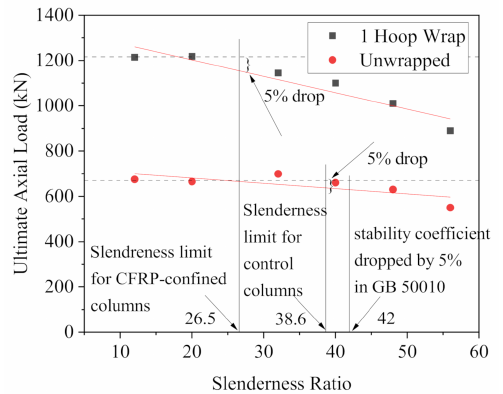
Figure 8. Effect of slenderness on ultimate axial